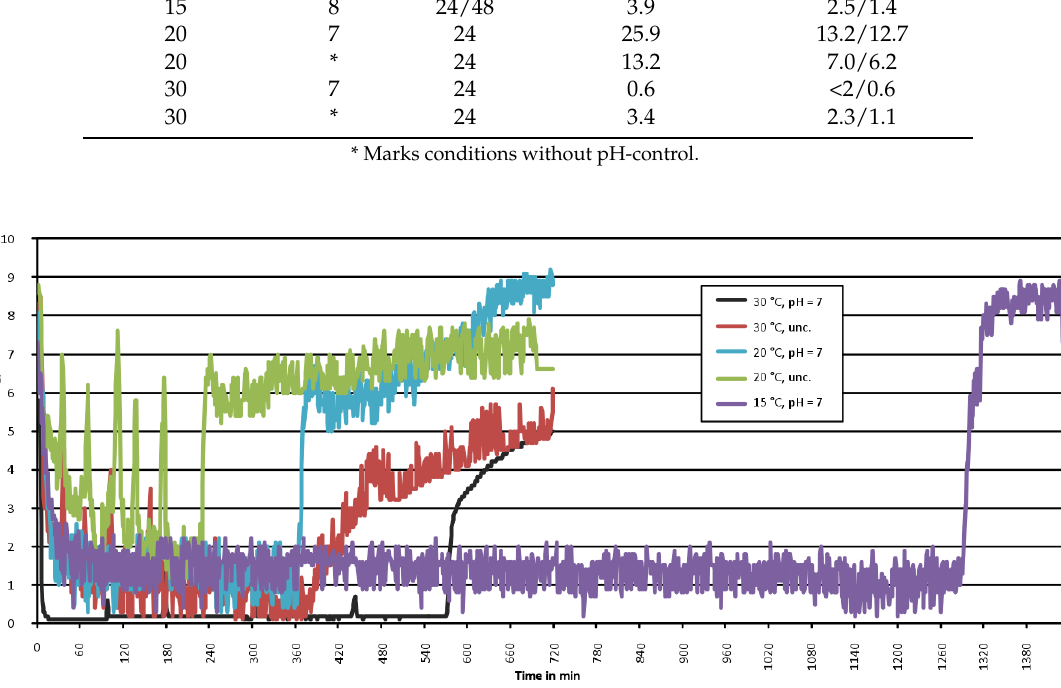
Figure 7. Reactor temperature influence on the feast/famine phase length.